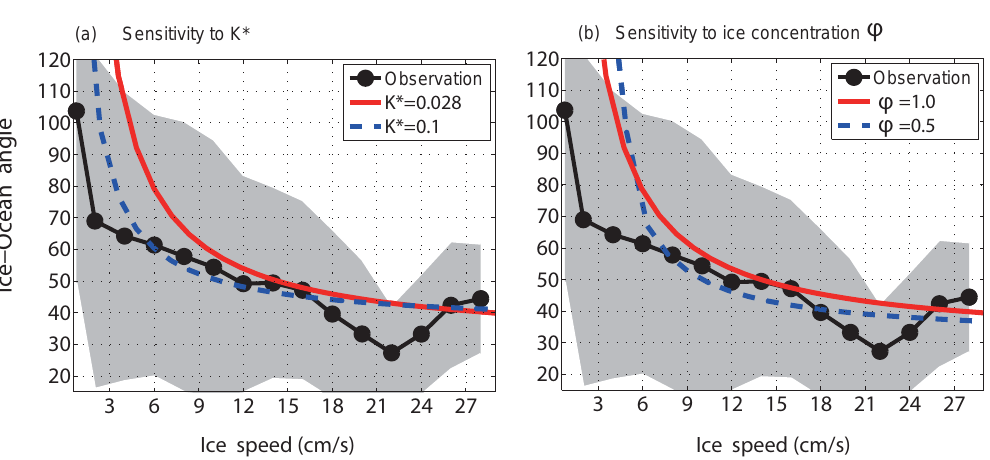
Figure 5. The velocity angle (clockwise rotation angle) between the ice floe and the ocean velocity at 7m depth, as functions of the ice speed (cms − 1 ). In each plot the black line is the mean observed value from the ITP-V 35 data set, binned by ice speed, and the gray shadings indicate the range of 1 standard deviation from the mean. In (a) , the red and blue lines correspond to our analytical model, described in Sect. 2, with vertical diffusivities K ∗ o = 0.028 and 0.1, respectively, and using 100% ice concentration, ϕ = 1. In (b) , the red and blue lines correspond to 100% ( ϕ = 1) and 50% ( ϕ = 0.5) sea ice concentrations, in each case using the canonical vertical diffusivity K ∗ o = 0.028.